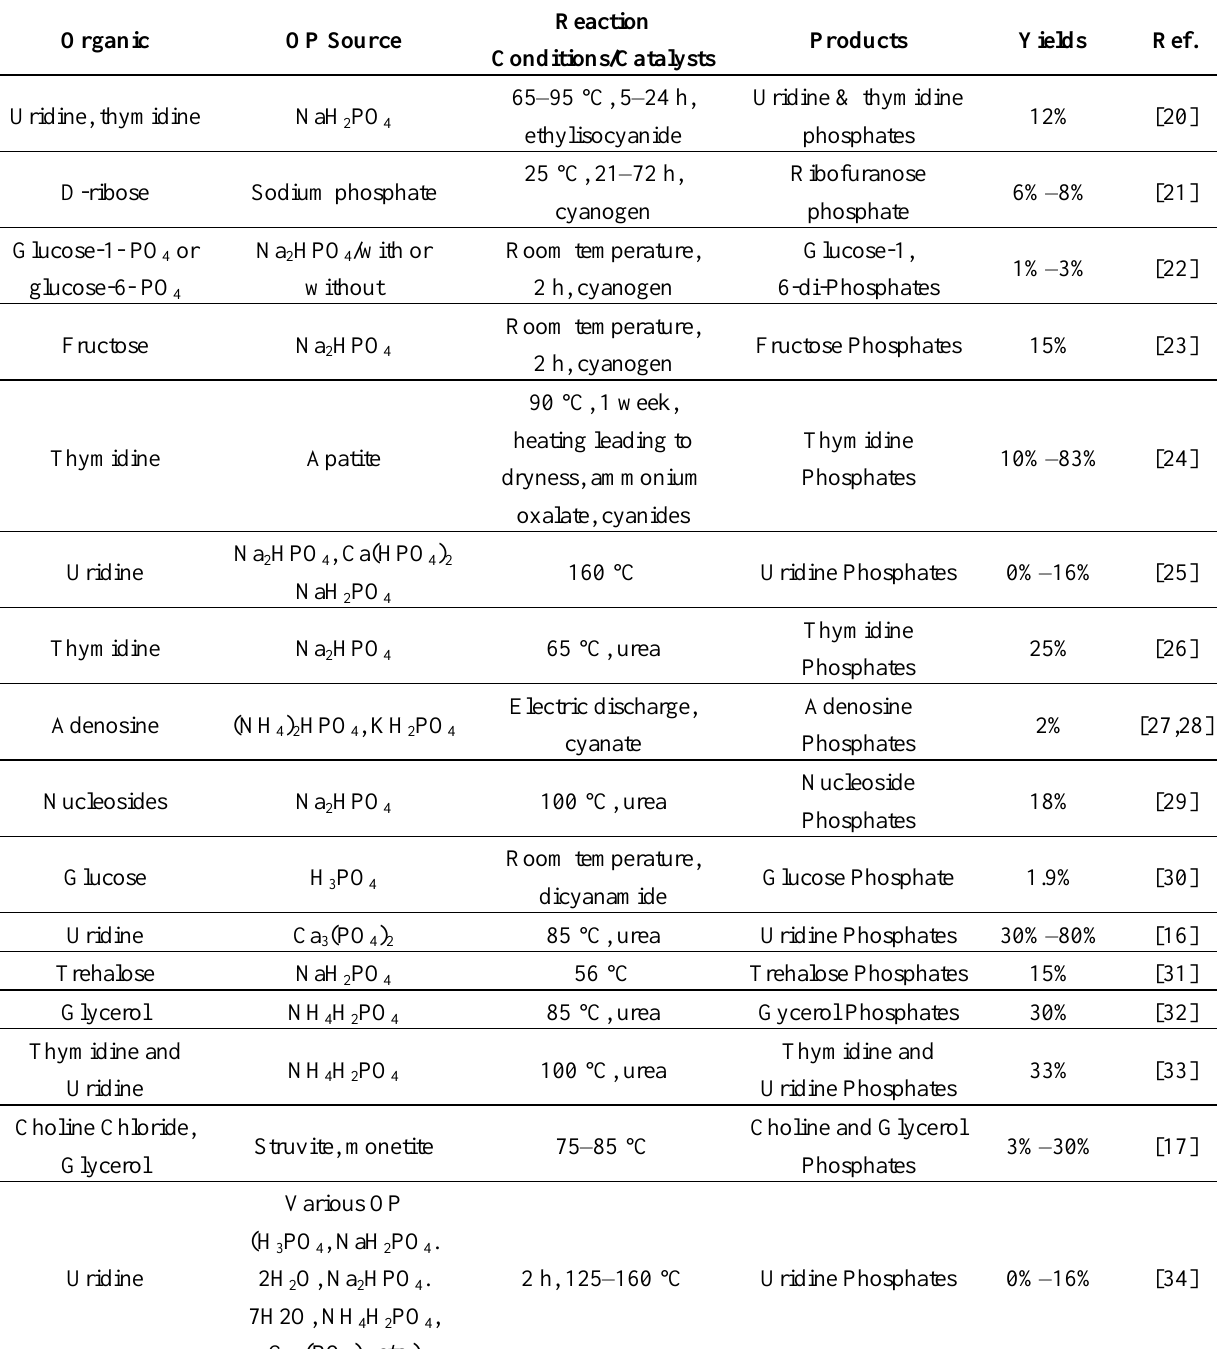
Table 1. Phosphorylation reactions by using OP as phosphate